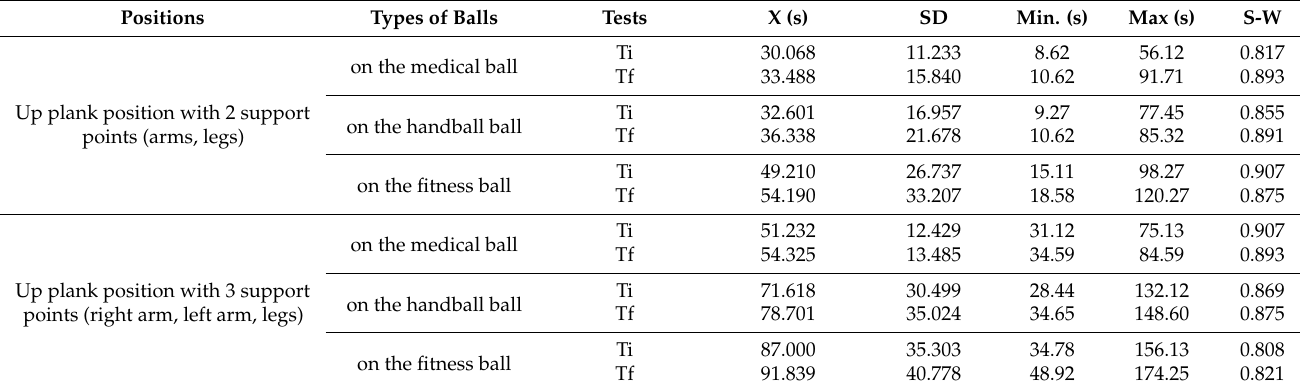
Table 1. Differences between initial and final tests of physical tests of maintaining balance on the three types of ball in the up plank position—for whole sample.